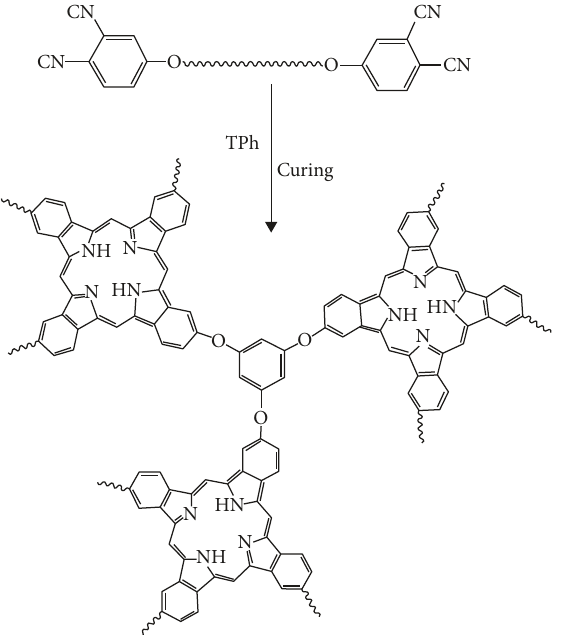
Figure 3: Formation of phthalocyanine rings from PEN and TPh.